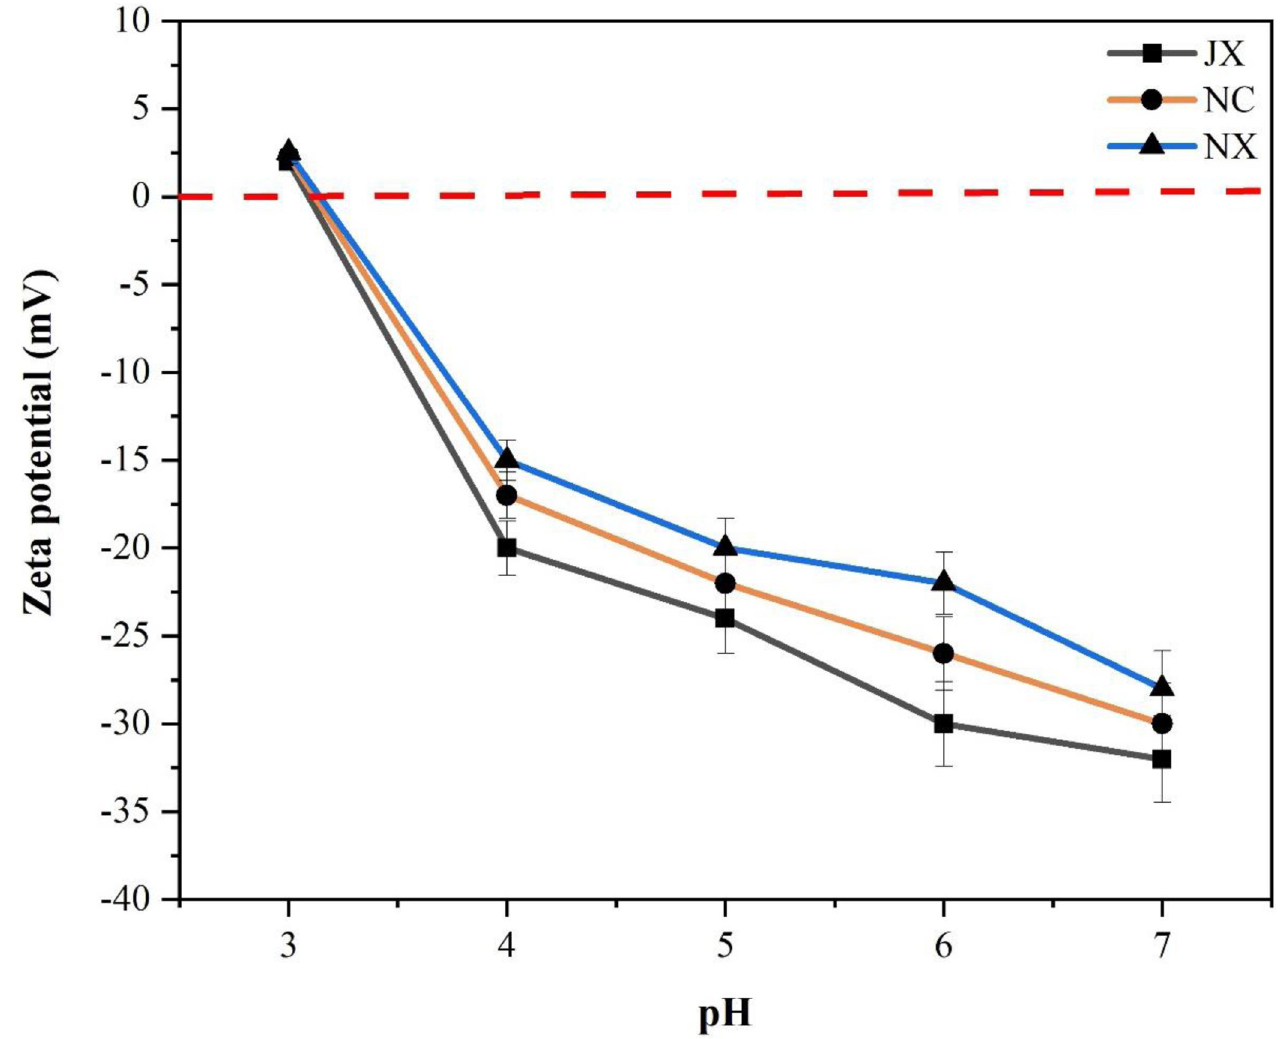
Fig 5. Curves of zeta potential vs. pH for red soils at three different experimental